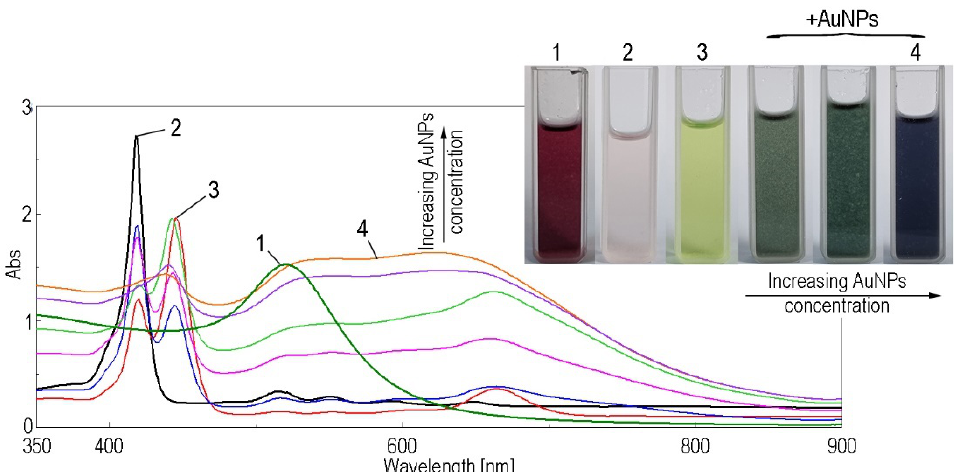
Figure 9. Overlapped UV-Vis spectra: gold colloid (1); (5-COOH-3MPP)-k-carrageenan composite material (2); acidified porphyrin-k-carrageenan composite material showing the diprotonated form of porphyrin (3); 5-COOH-3MPP porphyrin-k-carrageenan- AuNPs material (4).